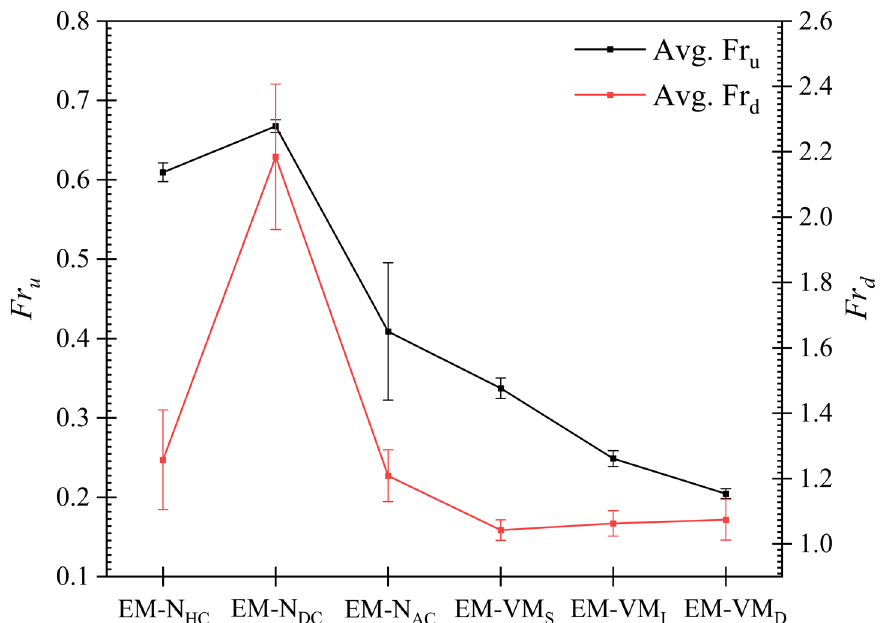
Figure 5. Variation of average Froude number at upstream and downstream concerning the case.